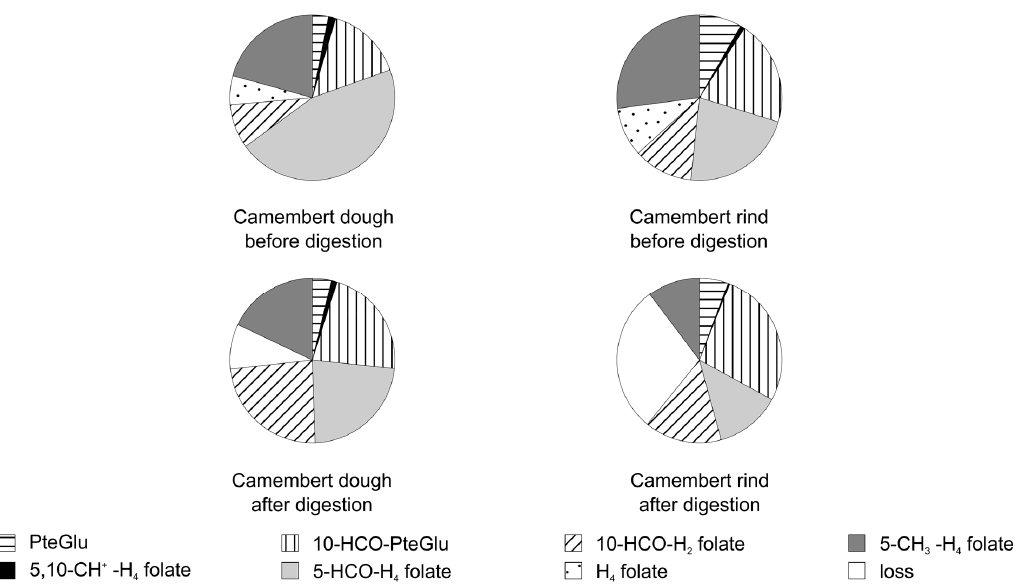
Figure 7. Folate distribution of the dough and rind of two different Camembert cheese varieties before and after the simulated digestion.